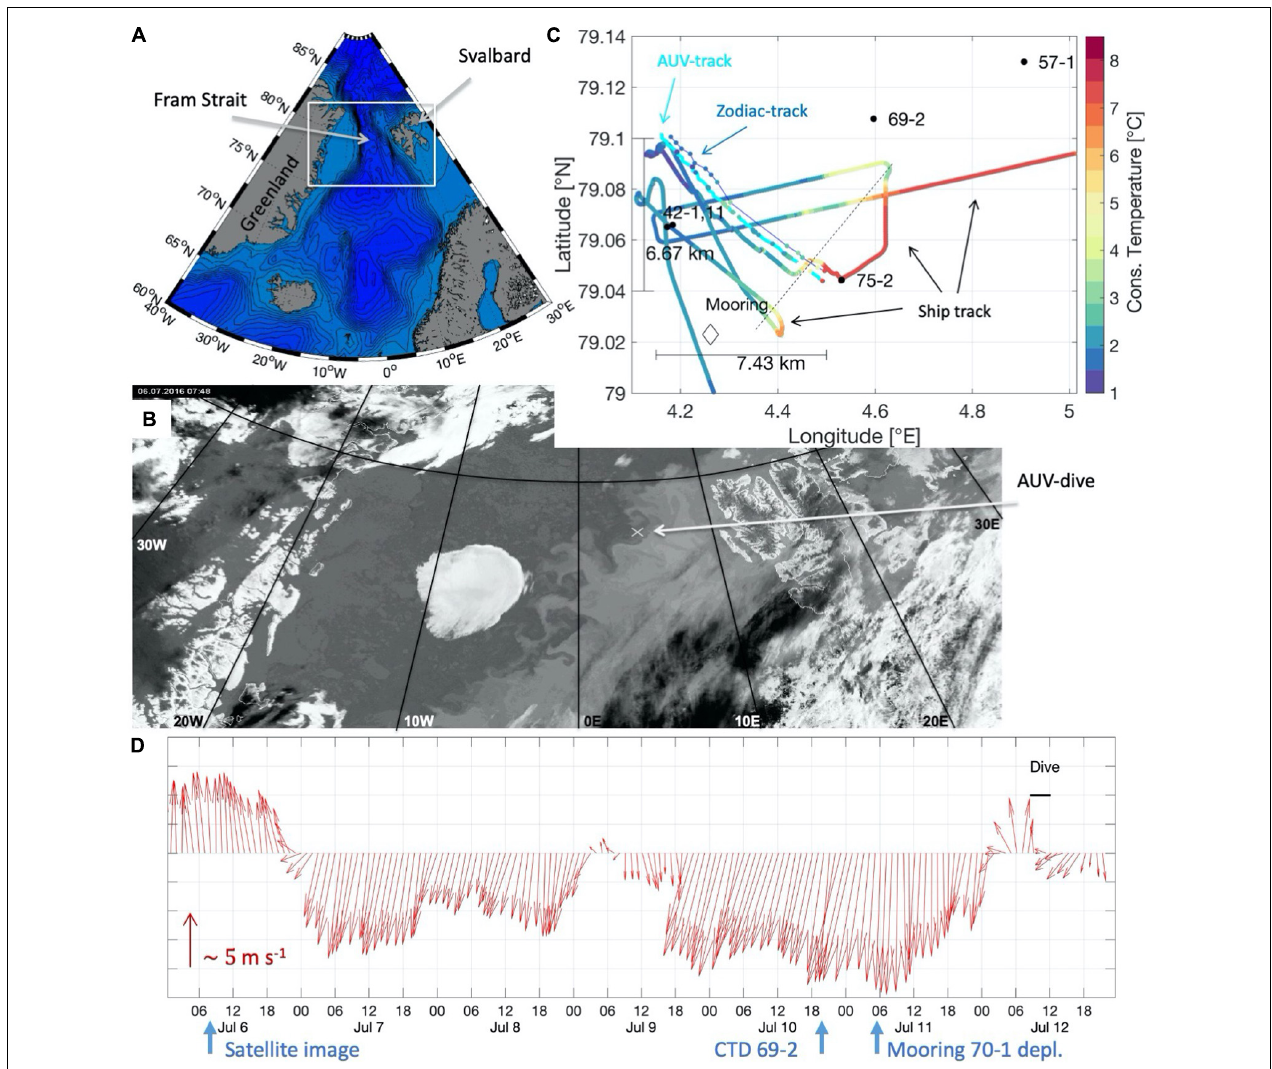
FIGURE 1 | (A) Topographic map of the Nordic Seas and Fram Strait. The study region is marked with a white box. (B) Infrared image taken on 6 July, 7:48 UTC of Fram Strait (channel 3 data of the AVHRR/3 instrument on the NOAA 15 satellite). The approximate location of the AUV-dive is marked by the white cross. (C) Sea surface temperature measured by the ship’s thermosalinograph at 5 m depth, and by the AUV and zodiac at 1 m depth. The AUV-track is marked in cyan, the zodiac-track is marked in blue. Black dots give shipboard CTD-station locations with station numbers. The black diamond indicates the position of the mooring. (D) One hour-averaged wind direction (arrow pointing into the down-wind direction) and wind speed (relative arrow length). The timing of the satellite image, the CTD station 69-2 and the mooring deployment 70-1 are indicated below the plot. The black bar indicates the time of the